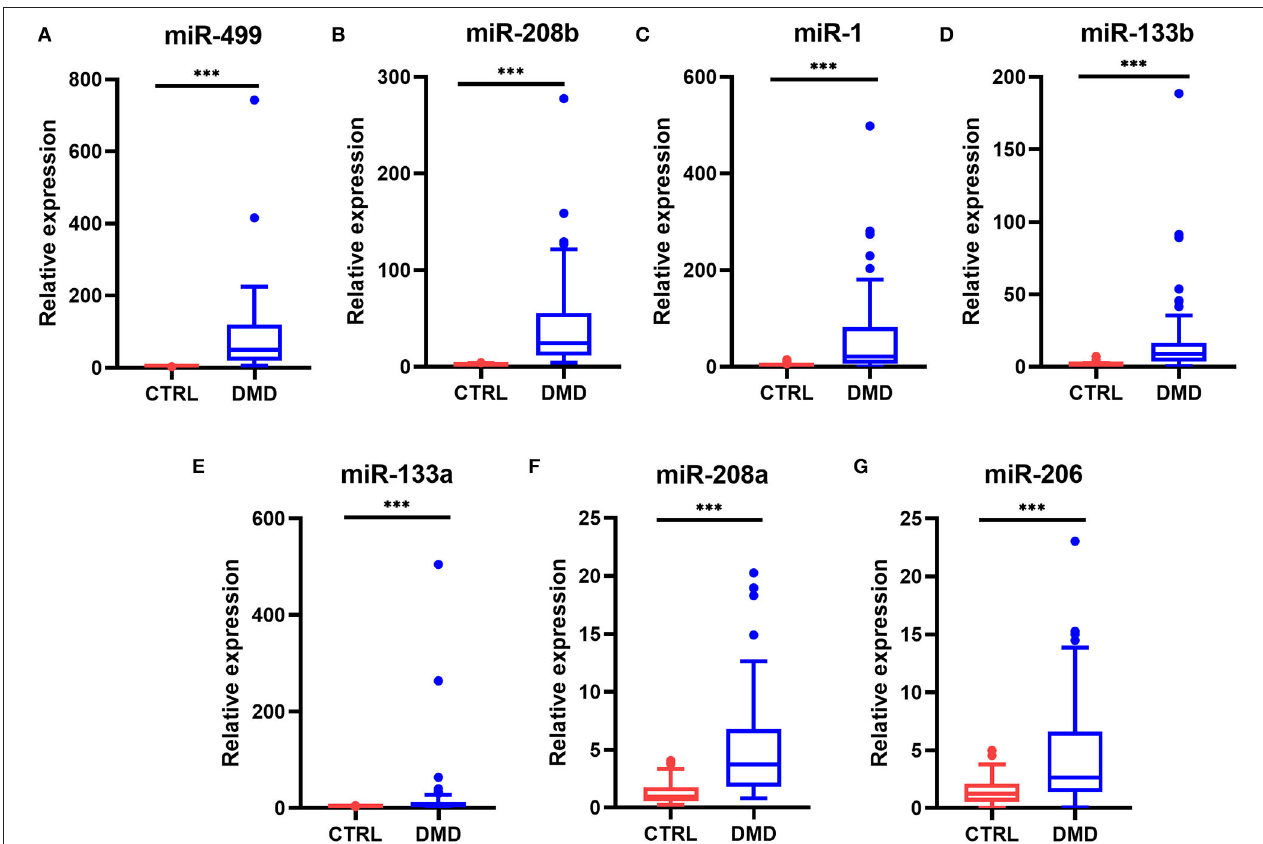
FIGURE 1 | Levels of myomiRs in the serum of DMD patients compared to controls. Serum levels of miR-499 (A) , miR-208b (B) , miR-1 (C) , miR-133b (D) , miR-133a (E) , miR-208a (F) , and miR-206 (G) in 53 healthy controls (red) and 48 DMD patients (blue) are shown as Tukey box plots. The lines within the boxes indicate the median levels, the box limits indicate first and third quartiles, the highest line means the Q3 + 1.5 IQR, lowest line means Q1 – 1.5 IQR, and individual points represent outliers. As data of both the DMD and control group were non-normally distributed variables, the non-parametric Mann–Whitney U-test was used for comparison between the two groups. All p- values were two-tailed, and p < 0.05 was considered statistically significant. *** p < 0.0001. DMD, Duchenne muscular dystrophy; CTRL, control.